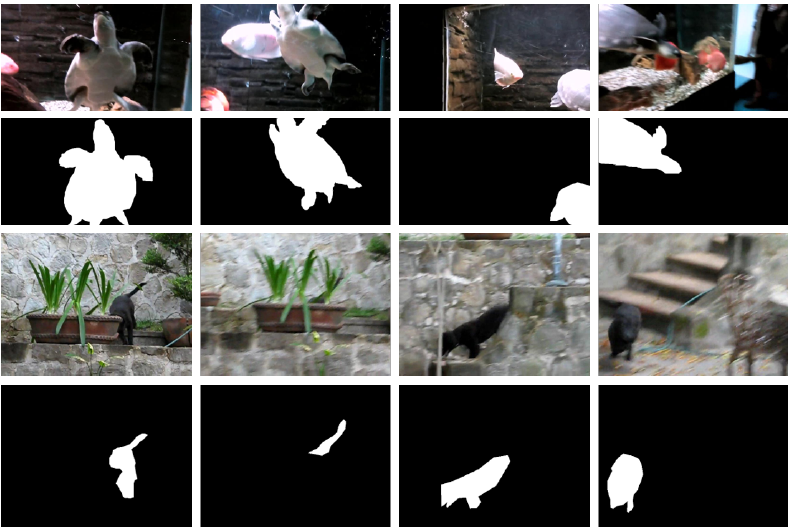
Figure 1. Primary objects may co-occur with or be occluded by various distractors. They may not always be the most salient ones in each separate frame but can consistently pop out in most video frames (the two groups of frames and masks are taken from the dataset VOS [15] and dataset Youtube-Objects [1],